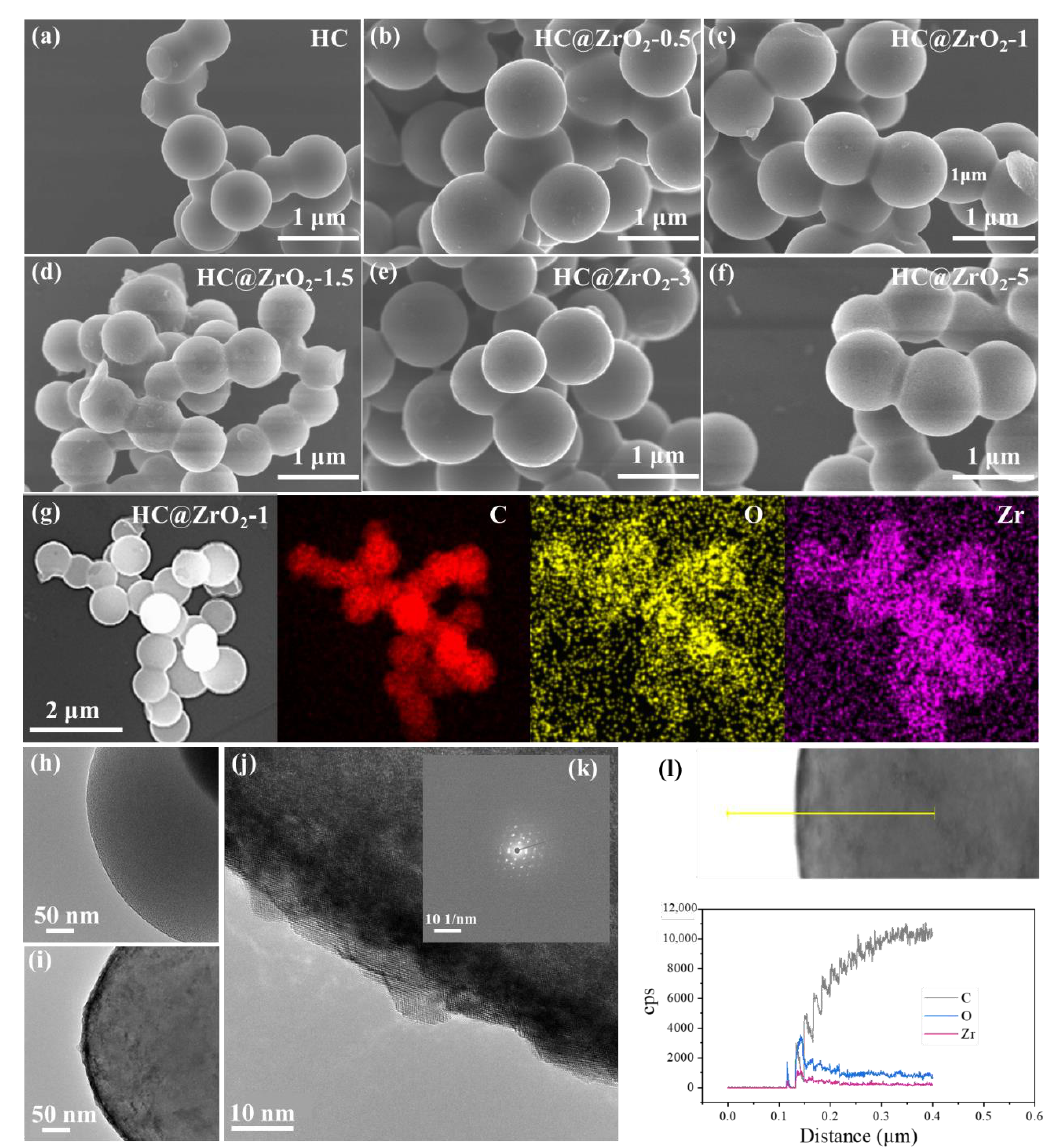
Figure 1. SEM images of HC ( a ) and HC@ZrO 2 ( b – f ) with different ZrO 2 content. ( g ) EDS elemental maps of HC@ZrO 2 -1. TEM images of HC ( h ) and HC@ZrO 2 -1 ( i , j ). ( k ) SAED image of HC@ZrO 2 -1. ( l ) TEM-DES line scan of HC@ZrO 2 -1.